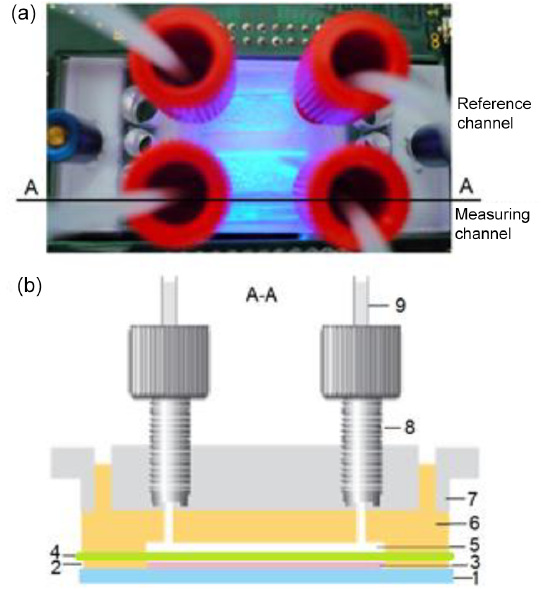
Figure 1. Design of the four-chamber microfluidic cell with mea- suring and reference channels: top view (a) and cross section through the measuring and reference channel, respectively (b)